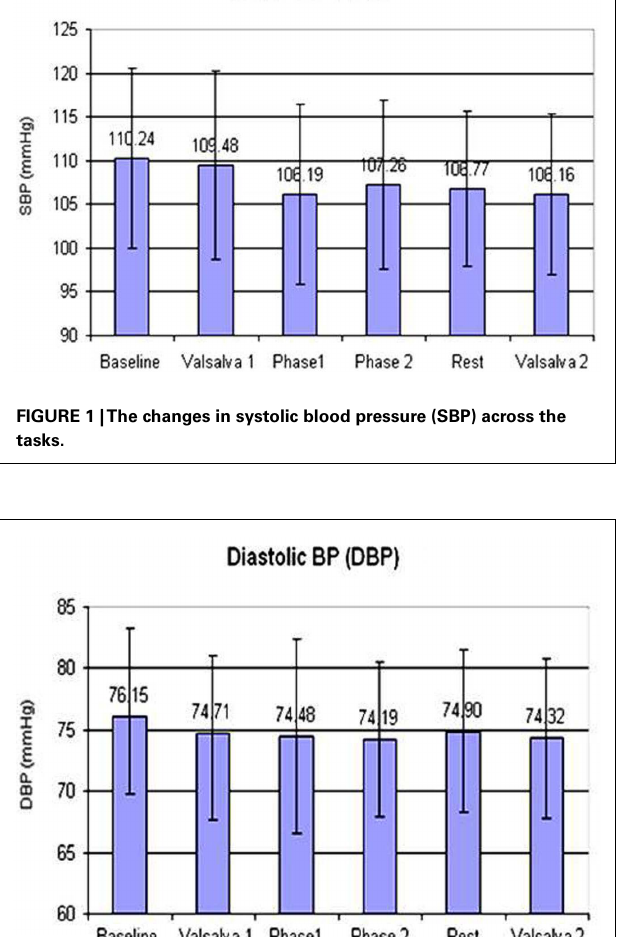
FIGURE 4 |The changes in oxygen saturation (SpO 2 ) across the